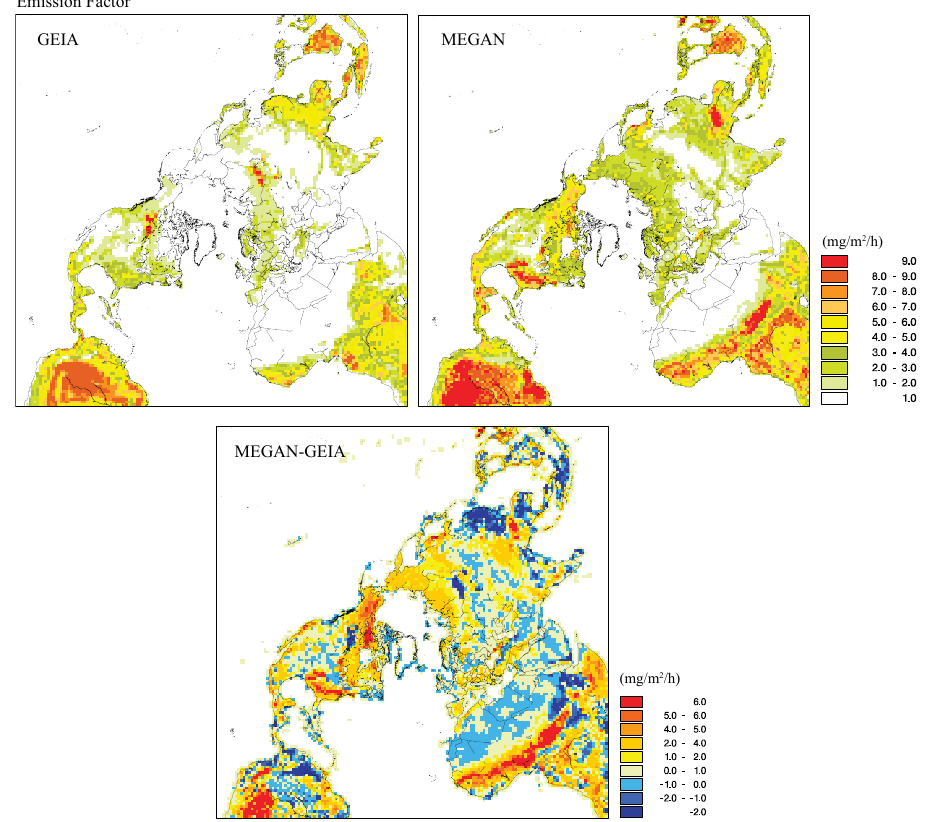
Fig. 3. Spatial variability of isoprene emission factors (mg isoprene m − 2 h − 1 ) used in the simulations with the MEGAN and GEIA models, together with their difference.